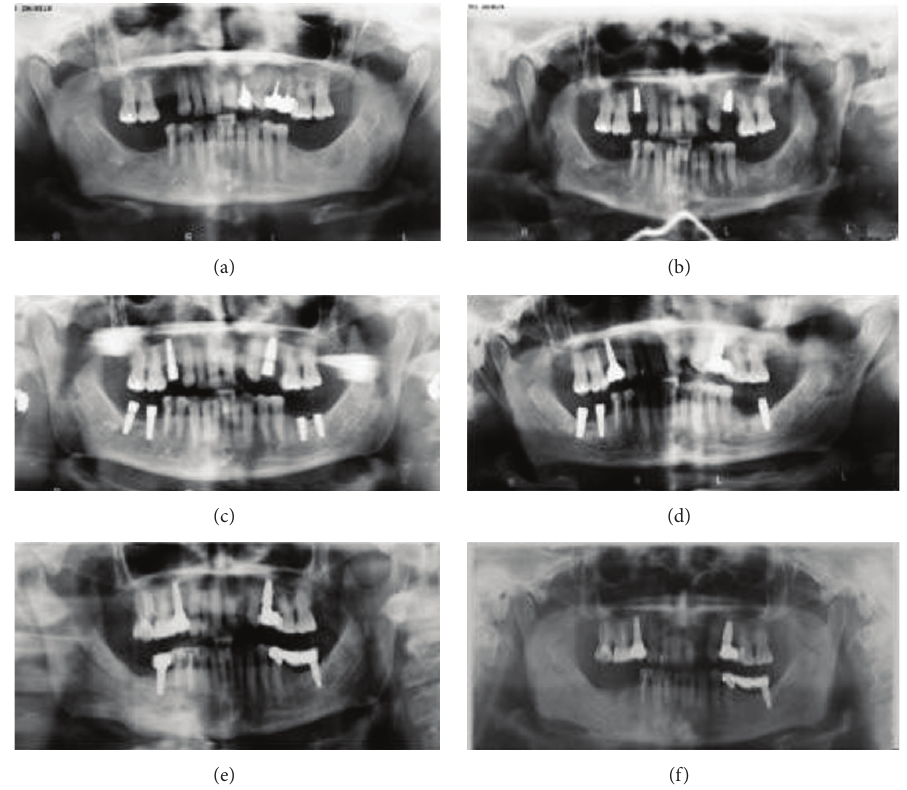
Figure 1: Orthopantomography (OPT) performed on 2009 (a), on May, 2010 (b), on September, 2010 (c), on May, 2011 (d), on August, 2011 (e), and on August, 2014 (f). The last one revealed osteosclerosis, osteolysis, and subperiosteal bone deposition and persistence of extraction